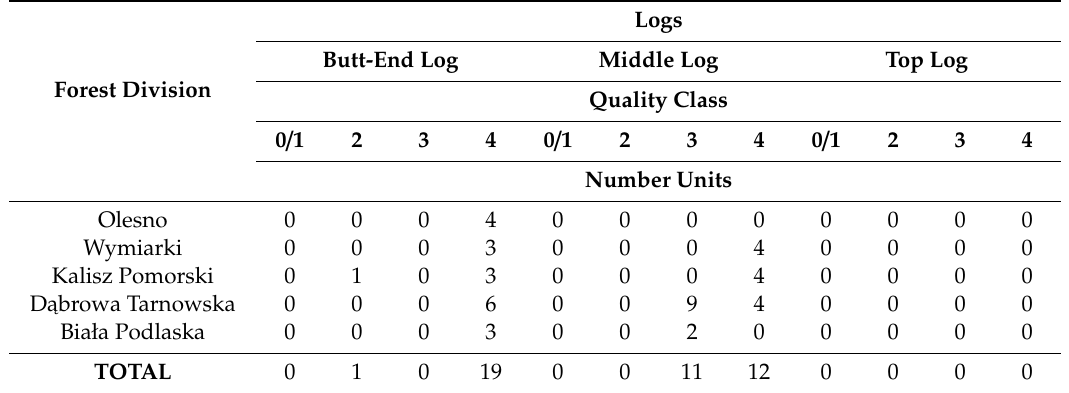
Table 19. Amount of sawn timber by defect: rot (PN-EN 1611-1).